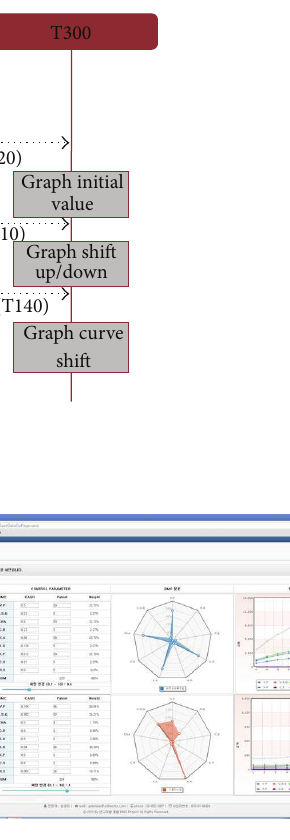
Figure 3: Simulation